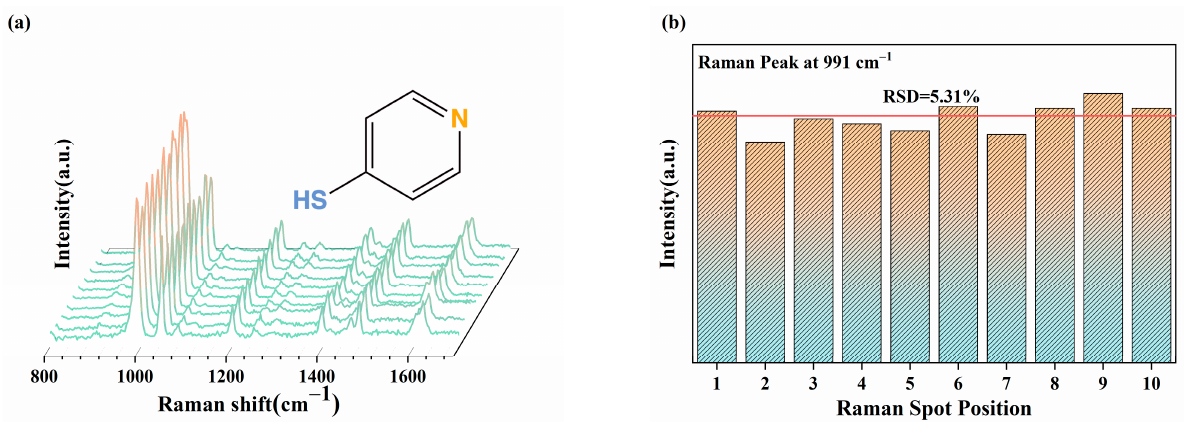
Figure 8. ( a ) SERS spectra of 10 − 2 M 4-Mpy acquired from 10 different spots on the 2%Nd-TiO 2 NPs substrate; ( b ) Raman intensity distribution at 991 cm − 1 from ( a ) for RSD calculation (the average peak intensity is indicated by the red line).